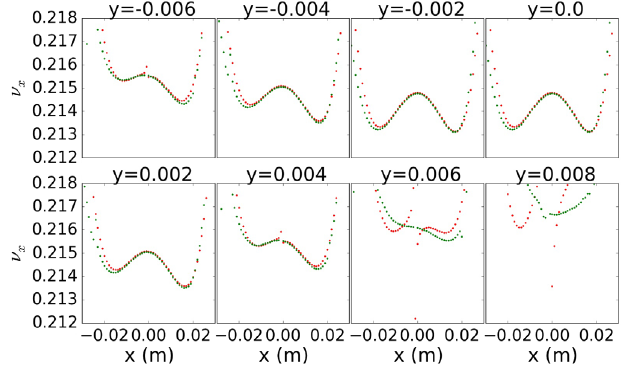
FIG. 9. Plots for ν as function of x for various y, compare x tracking (green) with theory (red).